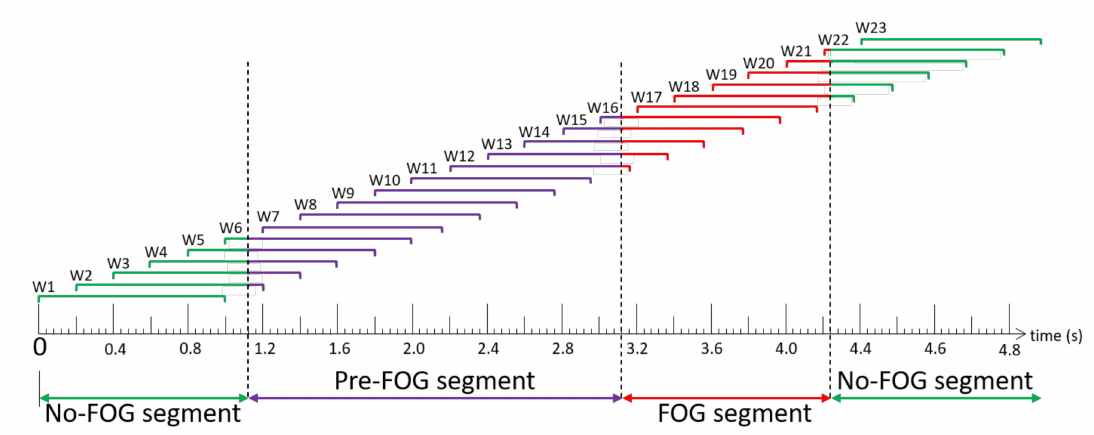
Figure 3. Freezing of gait (FOG) episode windowing scheme example. Windows (W) 1–6 are “No-FOG”, Windows 7–11 are “Pre-FOG”, Windows 12–16 overlap the Pre-FOG and FOG segments and are thus “Pre-FOG-Transition”, Window 17 is entirely in the FOG segment and is “FOG”, and Windows 18–23 extend or entirely occur beyond the end of the FOG episode and are “No-FOG”.